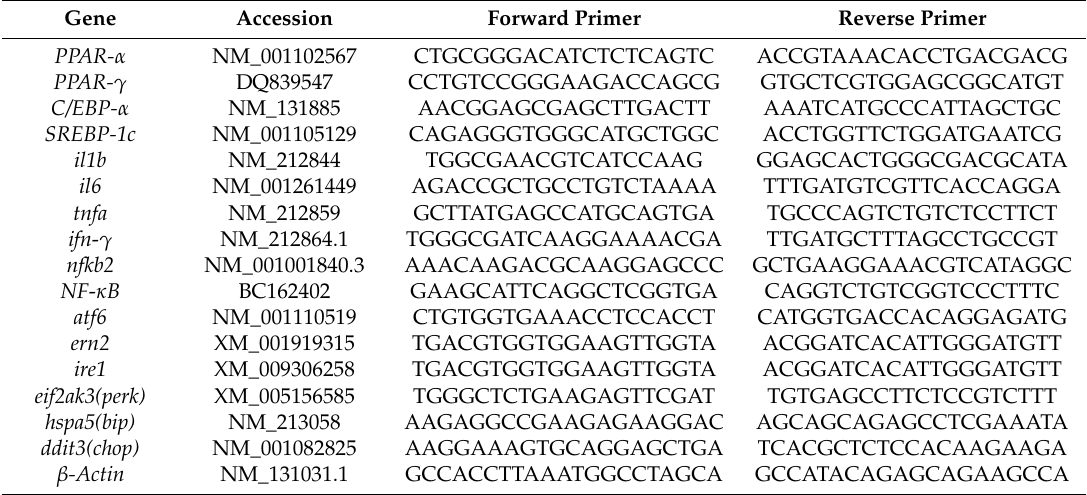
Table 1. Primer sequences used for this